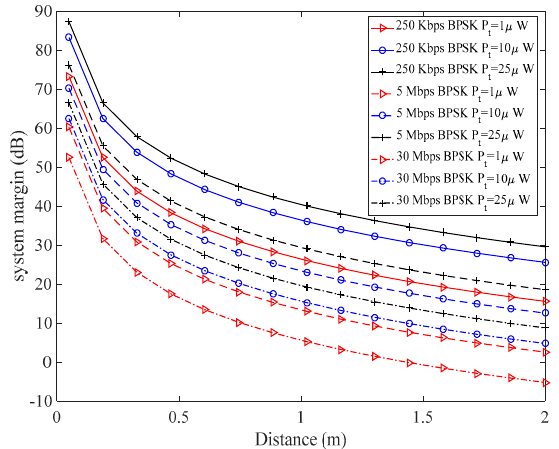
Figure 7. Link margin versus distance employing QPSK at multiple levels of data rates and powers.